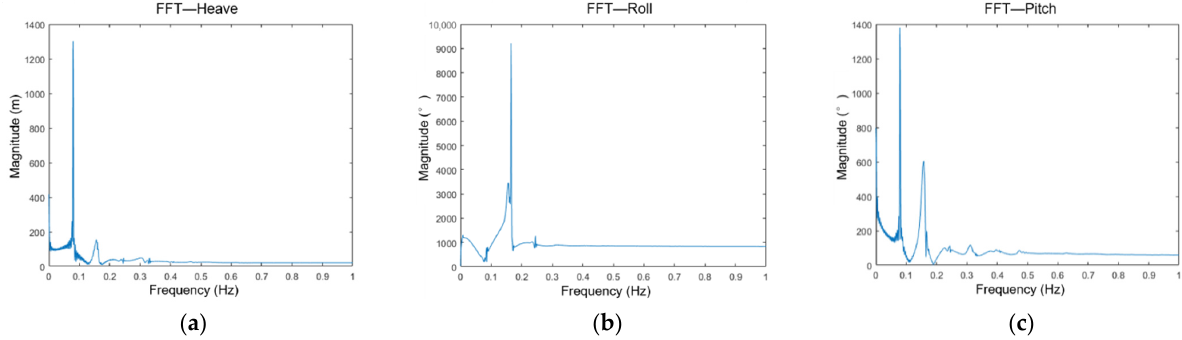
Figure 8. Simulated time-series motion plots of the case HB001HA100_SS06WA135 : ( a ) heave time- series plot, ( b ) roll time-series plot, and ( c ) pitch time-series plot.